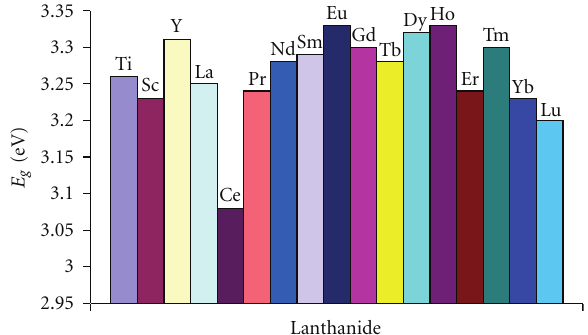
Figure 3: The comparison of the bandgap values of the investigated